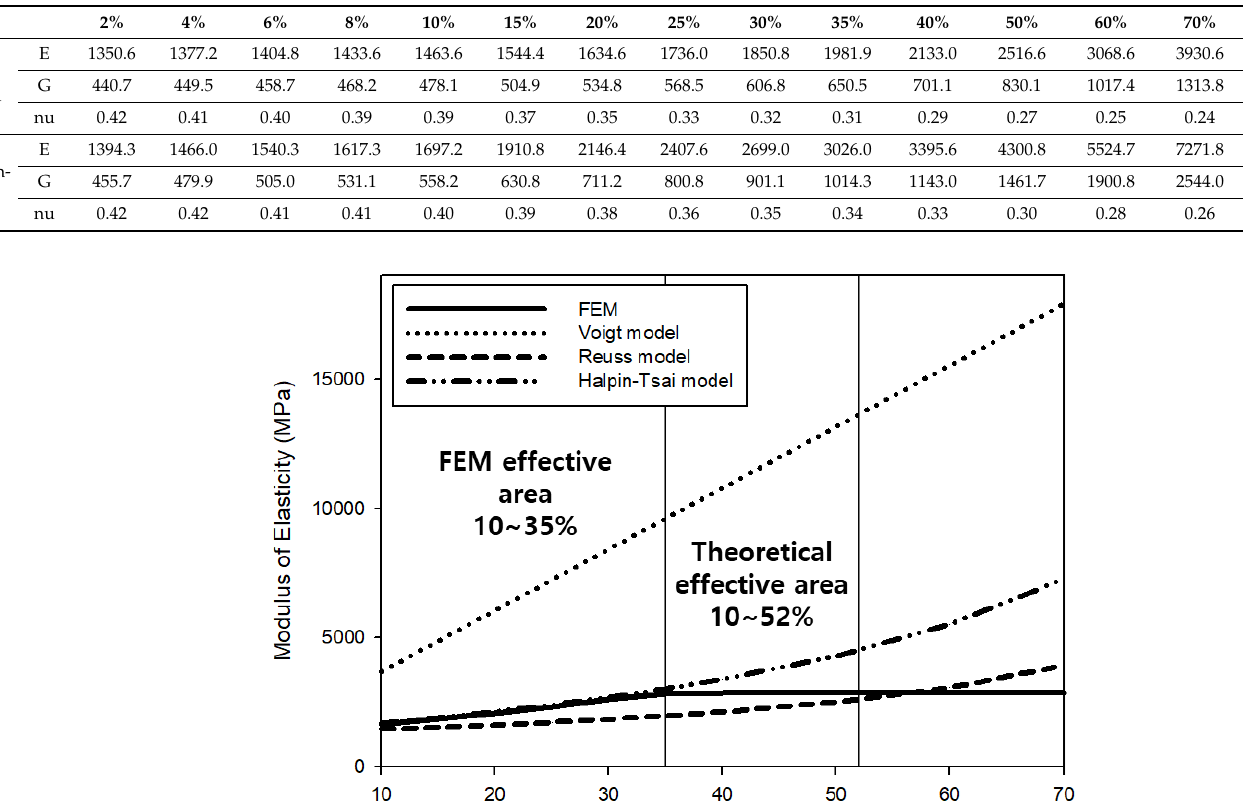
Figure 3. Values of Elastic modulus according to the volume fraction predicted by various models: Voigt, Reuss, Halpin – Tsai, and the finite element method (FEM).